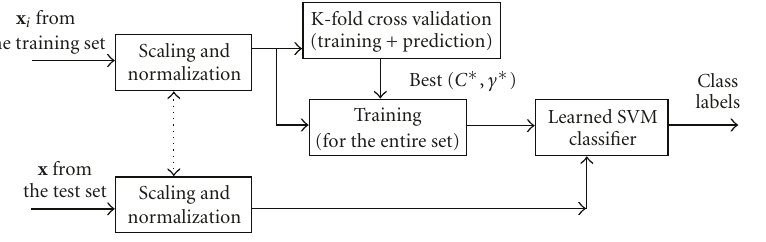
Figure 17: Block diagram for learning an RBF kernel SVM. The SVM is subsequently used as a classifier for input x from a test